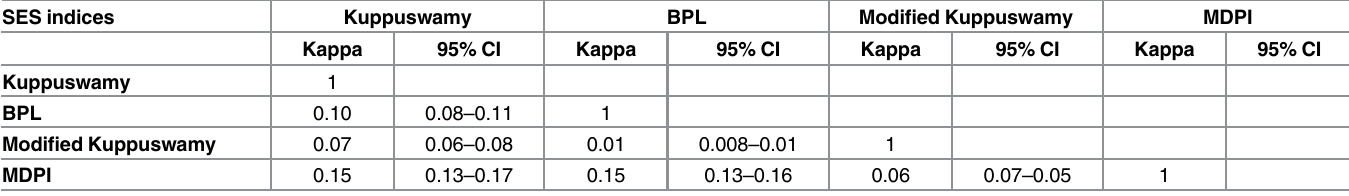
Table 4. Agreement (Kappa) between four